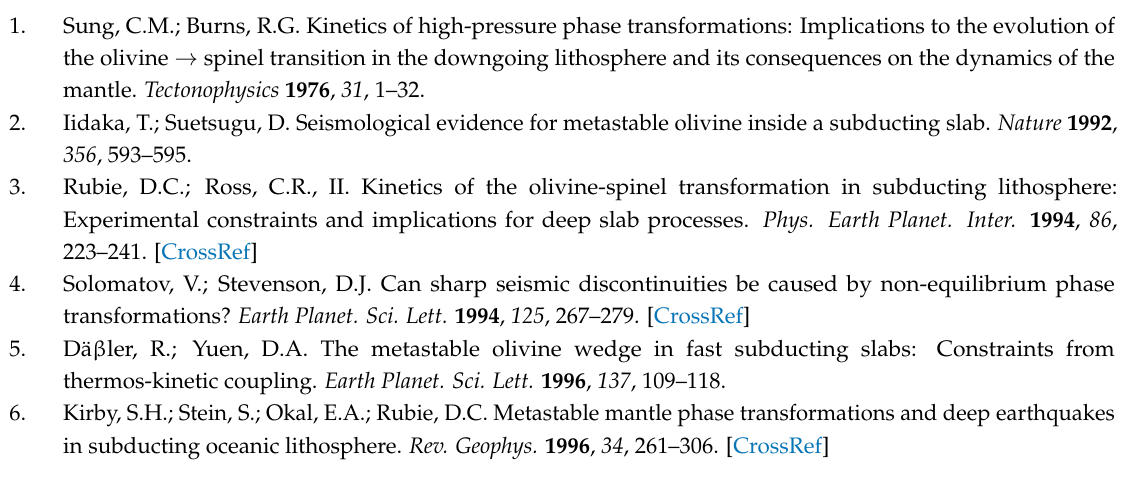
Figure S1: Calculated K T and K S of Fo-III at 0, 300, 600, 900, 1200, 1500 and 1800 K from 0 to 100 GPa using both GGA and LDA methods, Figure S2: Calculated α of Fo-III from 0 to 1800 K at 0, 10, 20, 30, 40, 50, 60, 70, 80, 90 and 100 GPa using both GGA and LDA method, Figure S3: Calculated γ th of Fo-III from 0 to 1800 K at 0, 10, 20, 30, 40, 50, 60, 70, 80, 90 and 100 GPa using both GGA and LDA method, Figure S4: Calculated C V and C P of Fo-III from 0 to 1800 K at 0, 10, 20, 30, 40, 50, 60, 70, 80, 90 and 100 GPa using both GGA and LDA method, Table S1: Fo at 0 GPa (0 K; GGA), Table S2: Fo-II at 0 GPa (0 K; GGA), Table S3: Fo-II at 60 GPa (0 K; GGA), Table S4: Fo-III